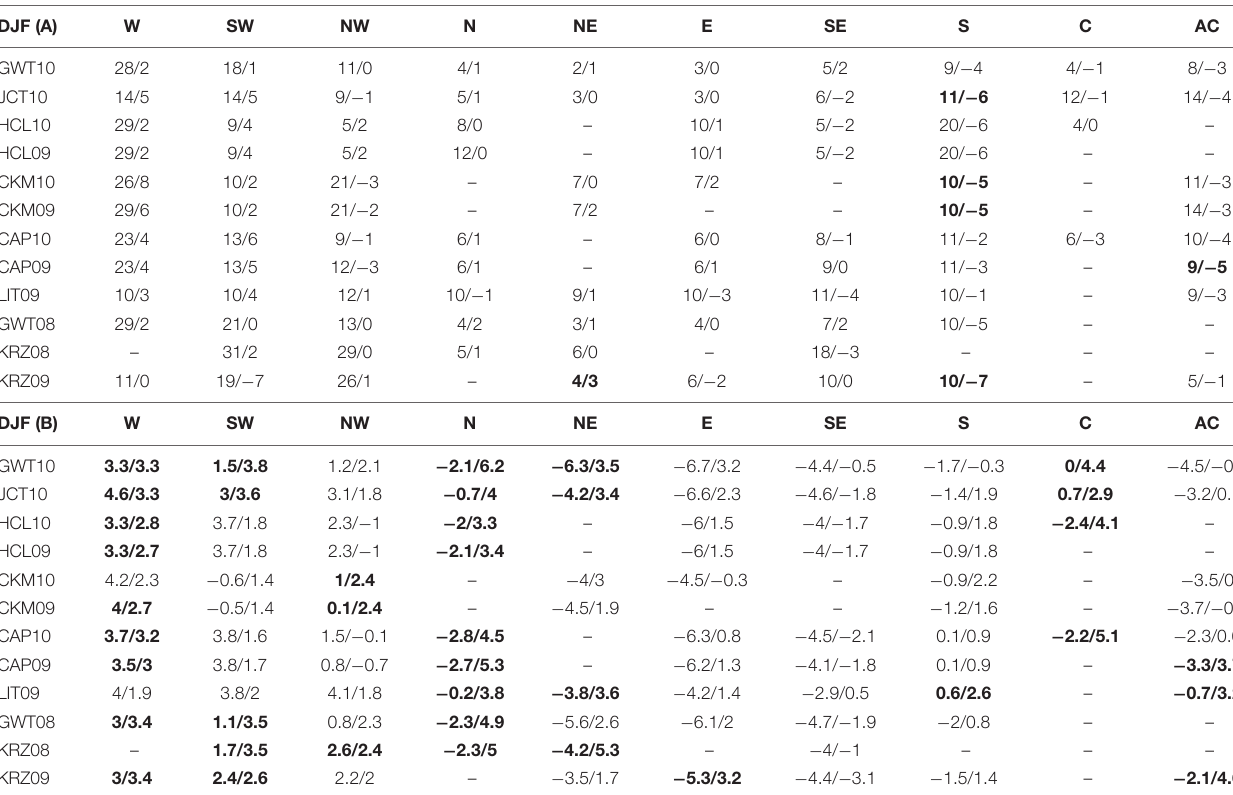
TABLE 4 | Long-term average (1966–2015) frequency of circulation types (in days) and changes by trend line in days per the period in winter [DJF (A)] and long-term average air temperature anomalies (in ◦ C) at Türi station associated with particular circulation types and changes by trend line in ◦ C in winter [DJF (B)]. DJF (A) W SW